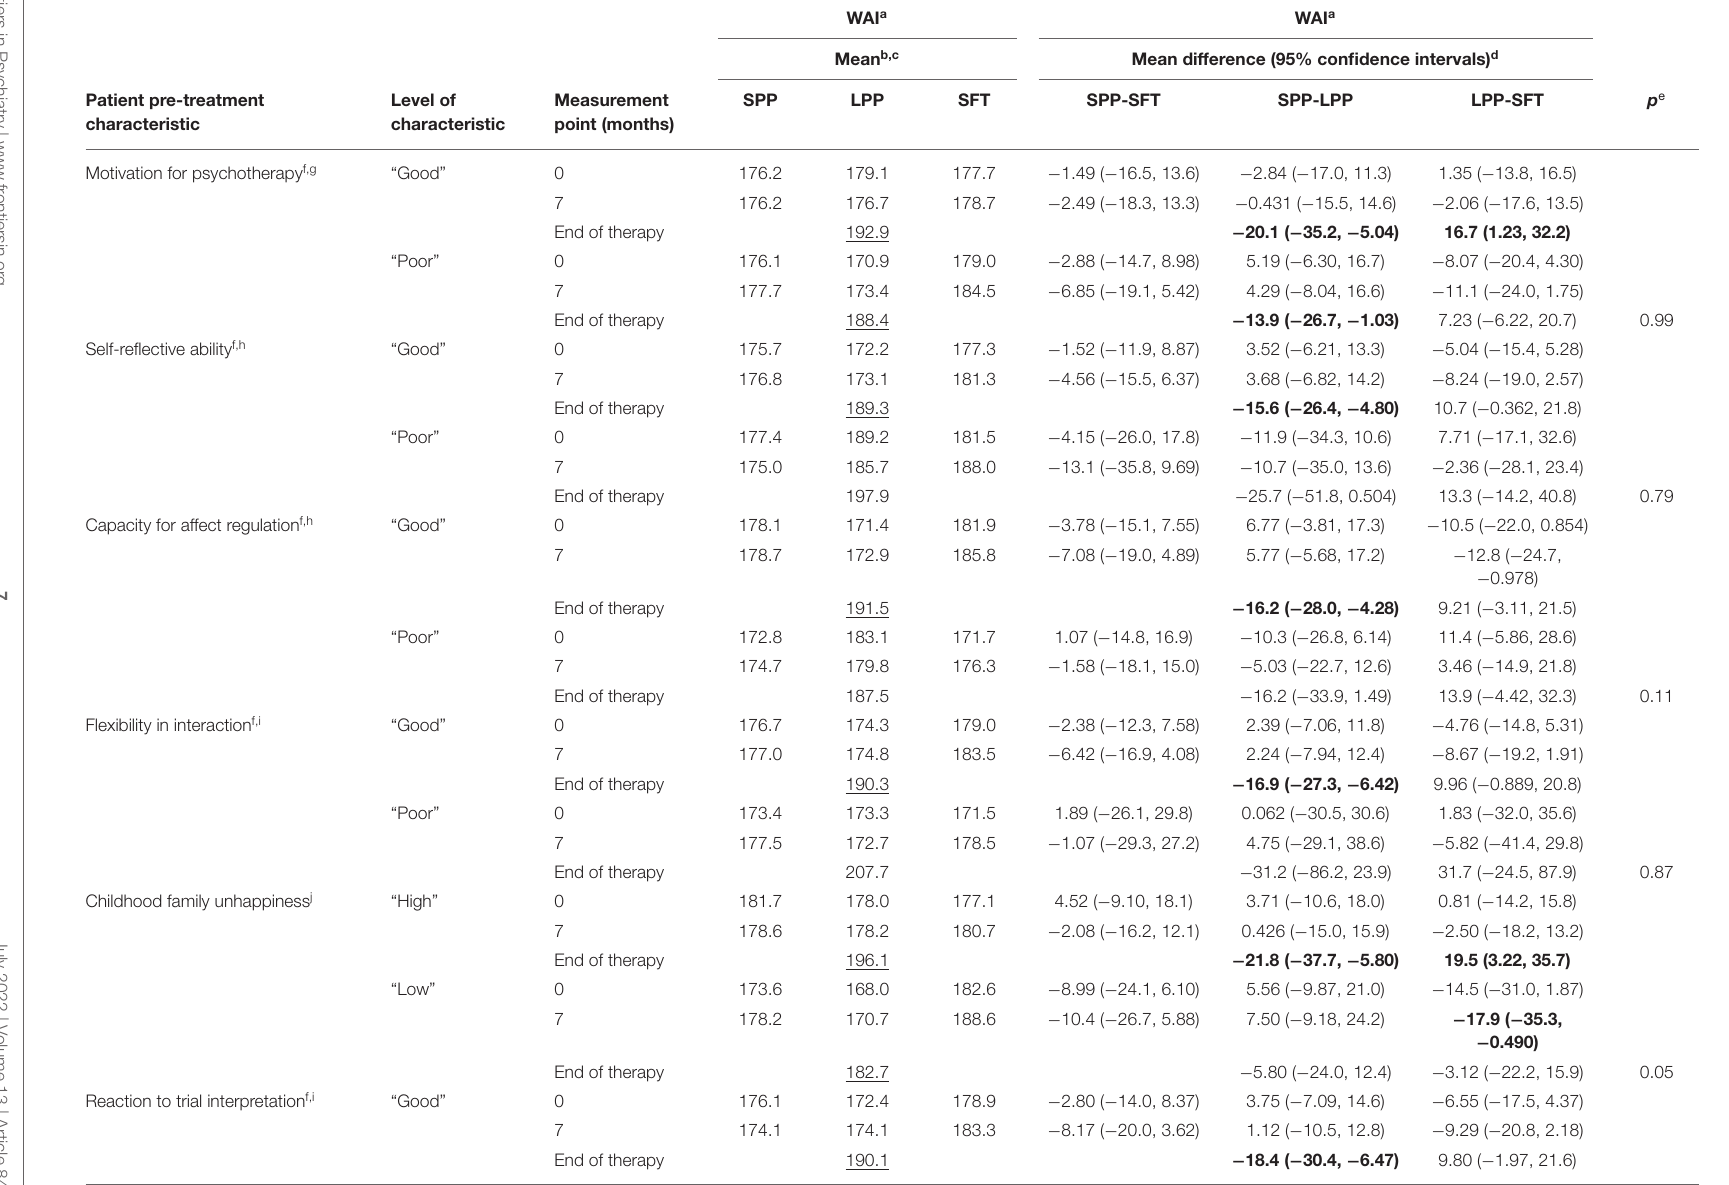
TABLE 2 | Estimated working alliance mean values and differences in short-term and long-term psychodynamic and solution-focused